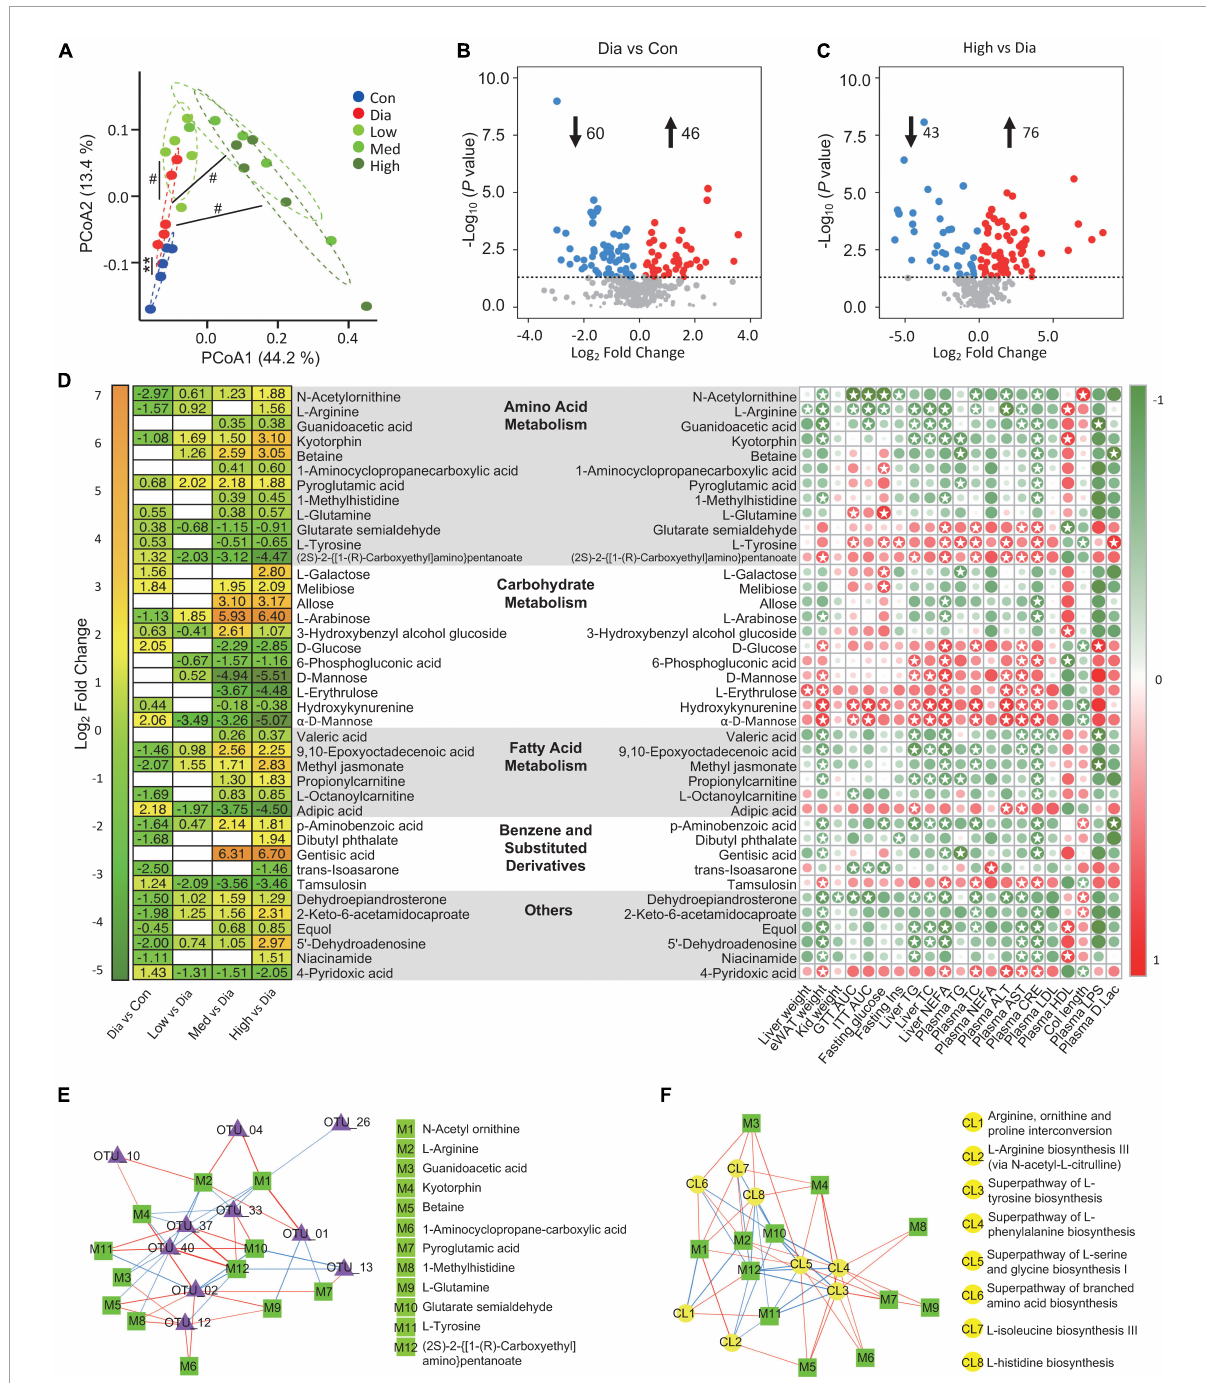
FIGURE7 CFP administration alters the plasma metabolome. (A) Bray-Curtis Dissimilarity of MS/MS extracts from the experimental groups. ∗∗ P < 0.01 vs. control; # P < 0.05 vs. Dia. (B) Volcano plot of differently expressed metabolites in the diabetic mice compared with the control ones. (C) Volcano plot of differently expressed metabolites in the high dose CFP-treated mice compared with the diabetic ones. (D) Statistic of differently expressed metabolites and correlation analysis with diabetes-related parameters. (Left) Heatmap of differently expressed metabolites from the experimental groups. (Right) Correlation analysis of metabolites with the physiological indexes. The intensity of the colors represents the degree of association between the levels of metabolites and host parameters assessed by Pearson correlation analysis. Stars means P < 0.05. (E,F) Network map depicting the relationships between metabolites and the composition (E) or the function (F) of gut microbiota. The red line means positive relationship, whereas the blue line means negative